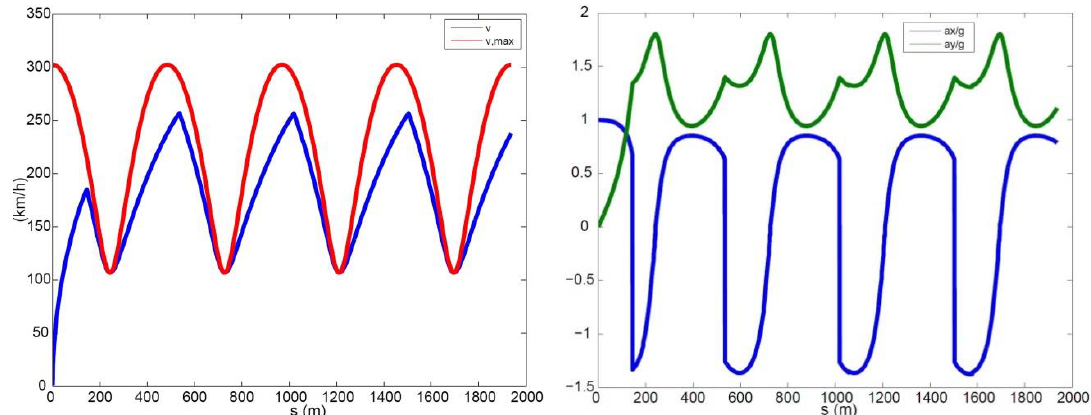
Figure 8. Ellipse, no aerodynamics: (left) speed and (right) accelerations with respect to 𝑠 .